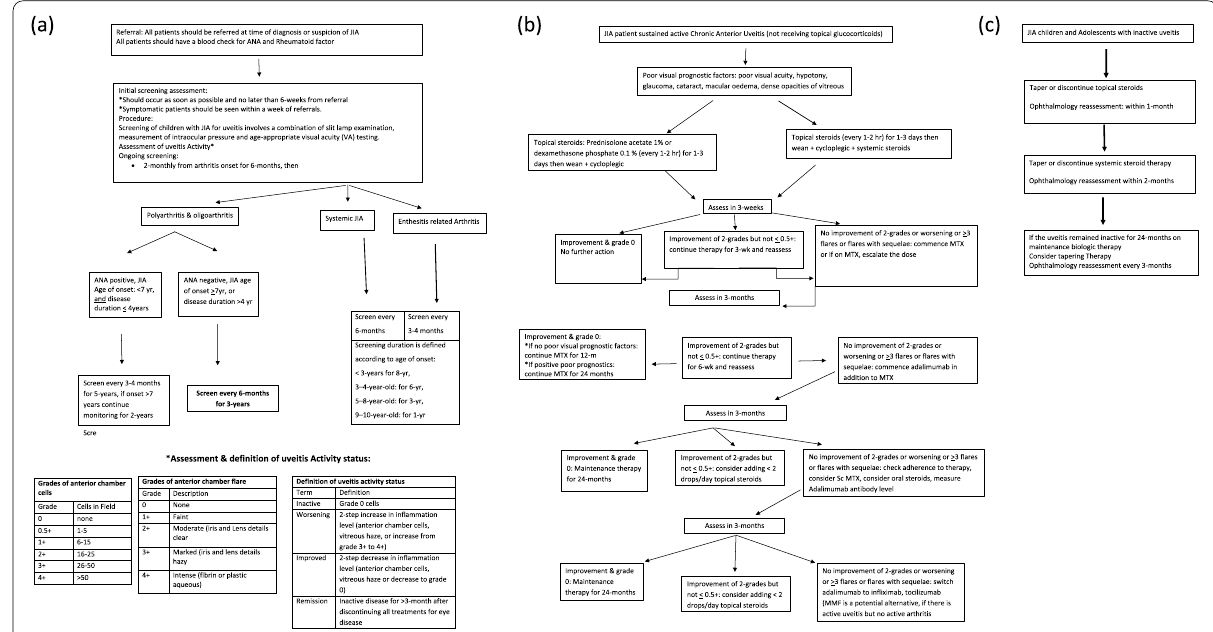
Fig. 5 a Algorithm for screening, referral, and monitoring of chronic anterior uveitis in children and adolescents with